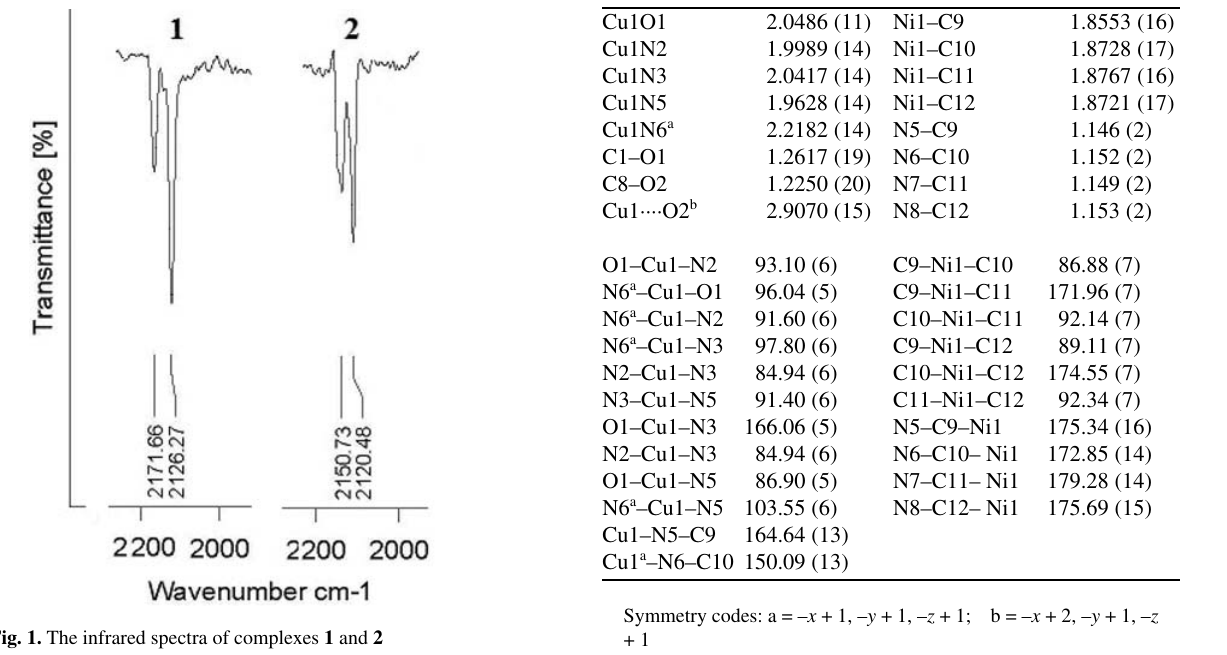
Fig. 2. The structure of the [ Cu(bcen)Ni(CN) labelling of selected atoms. Anisotropic displacement ellipsoids ex- hibit 30% probability levels. Hydrogen atoms are drawn as circles with small